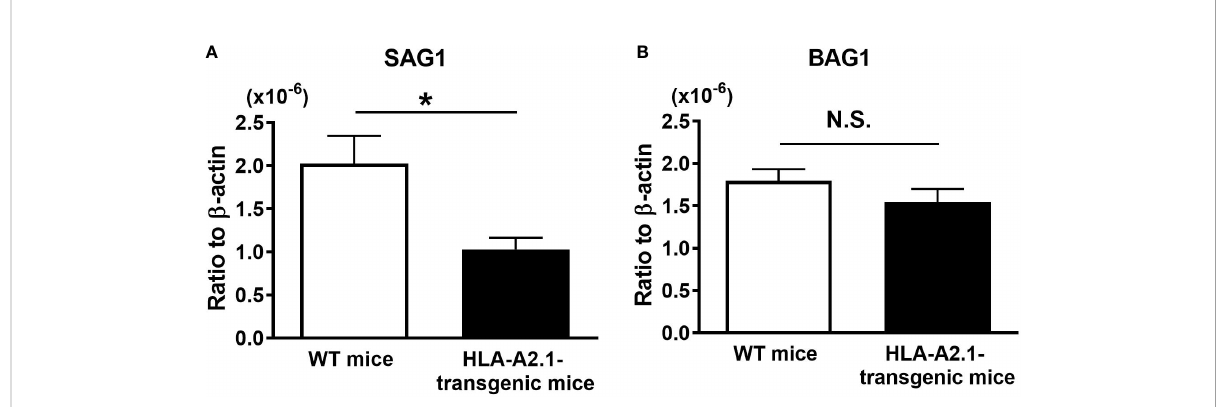
FIGURE 1 Transgenic mice expressing human HLA-A2.1-have lower tachyzoite burden in their brains than do WT control mice during reactivation of cerebral infection with T. gondii . The HLA-A2.1-transgenic and WT control mice were infected with 10 cysts of the ME49 strain and treated with sulfadiazine beginning at 7 days after infection for 10 days to control tachyzoite proliferation during the acute stage of infection and establish chronic infection in their brains. Four to fi ve weeks after the discontinuation of sulfadiazine, which induces reactivation of the cerebral infection, the ratios of mRNA levels for (A) tachyzoite-speci fi c SAG1 and (B) bradyzoite (cyst)-speci fi c BAG1 against mRNA levels for b -actin were measured by real-time RT-PCR on the brains. * P <0.05. N.S. Not signi fi cant. The data were combined from three independent experiments (n=11 for the HLA-transgenic mice, and n=14 for the WT control